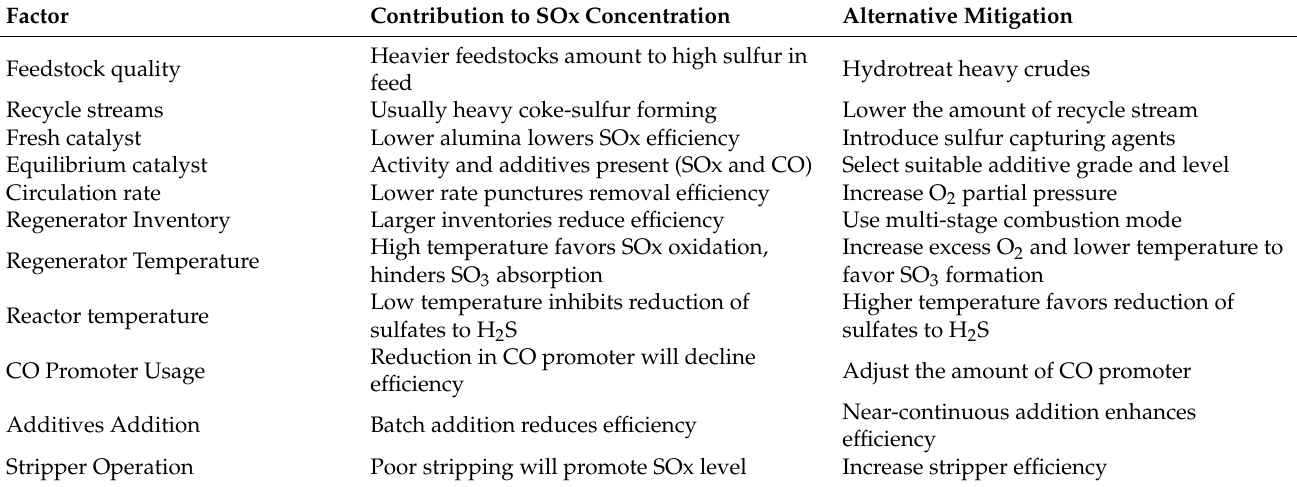
Table 9. Causes of FCC flue gas SOx